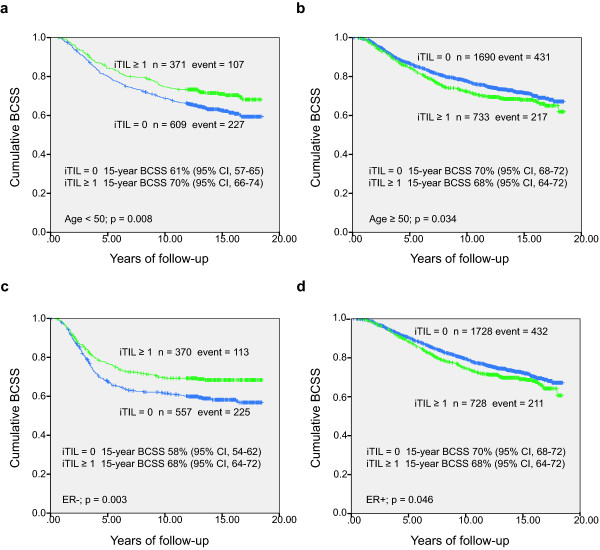
Breast cancer-specific survival (BCSS) by intratumoral tumor-infiltrating lymphocytes (iTILs) among groups with different age and estrogen receptor (ER) status. (a) Age of less than 50 years, (b) age of at least 50 years, (c) ER-, and (d) ER+. CI, confidence interval.